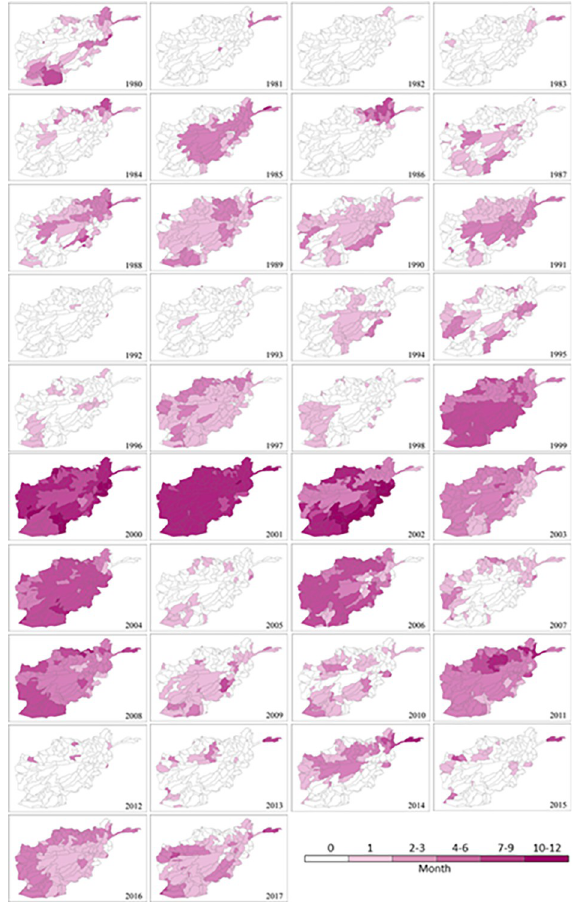
Fig 8. Spatial distribution of annual maximum drought duration at sub-catchment scale in Afghanistan for each year between 1980 and 2017 based on SPEI-3 (seasonal scale).